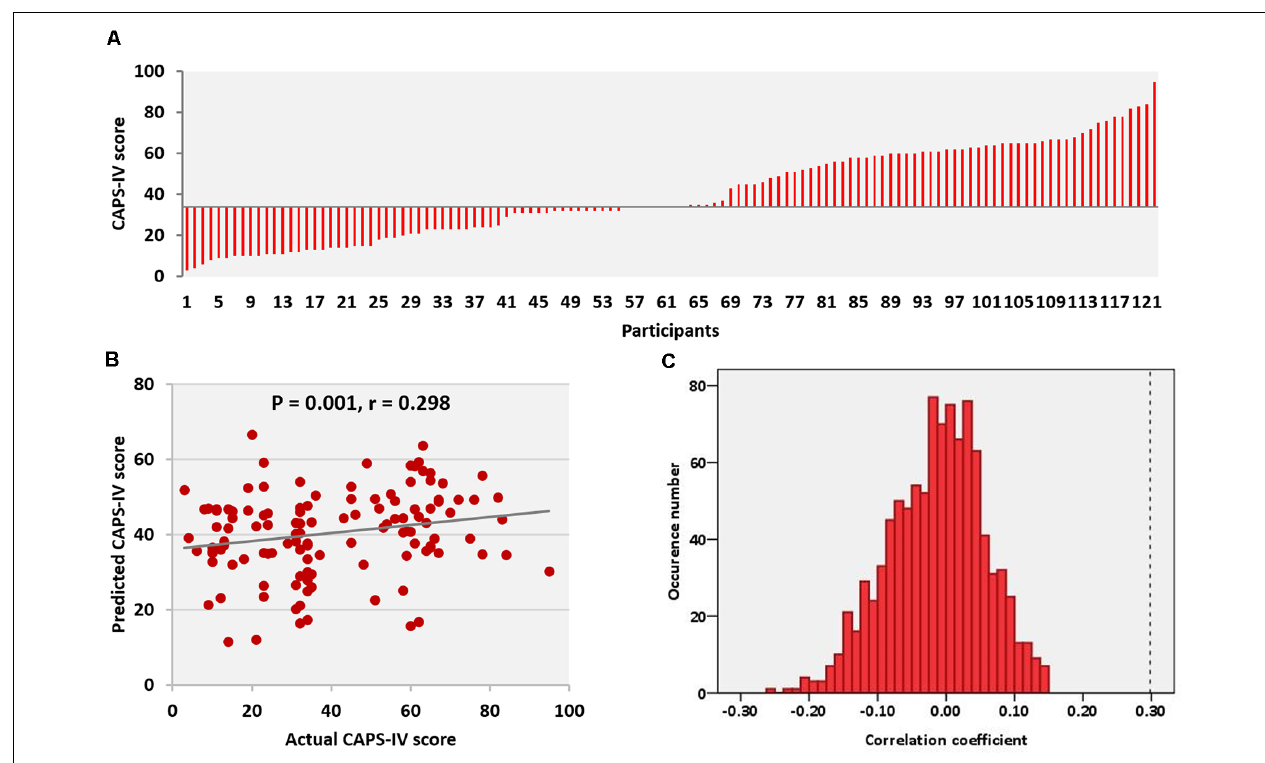
FIGURE 1 | Clinician Administered Post-traumatic Stress Disorder Scale (CAPS-IV) scores and performance of the prediction model. (A) CAPS-IV scores across all participants. (B) Correlation between actual and predicted CAPS-IV scores. (C) Permutation distribution of the correlation coefficient ( r ) for the prediction analysis. CAPS, clinical-administered post-traumatic stress disorder (PTSD)